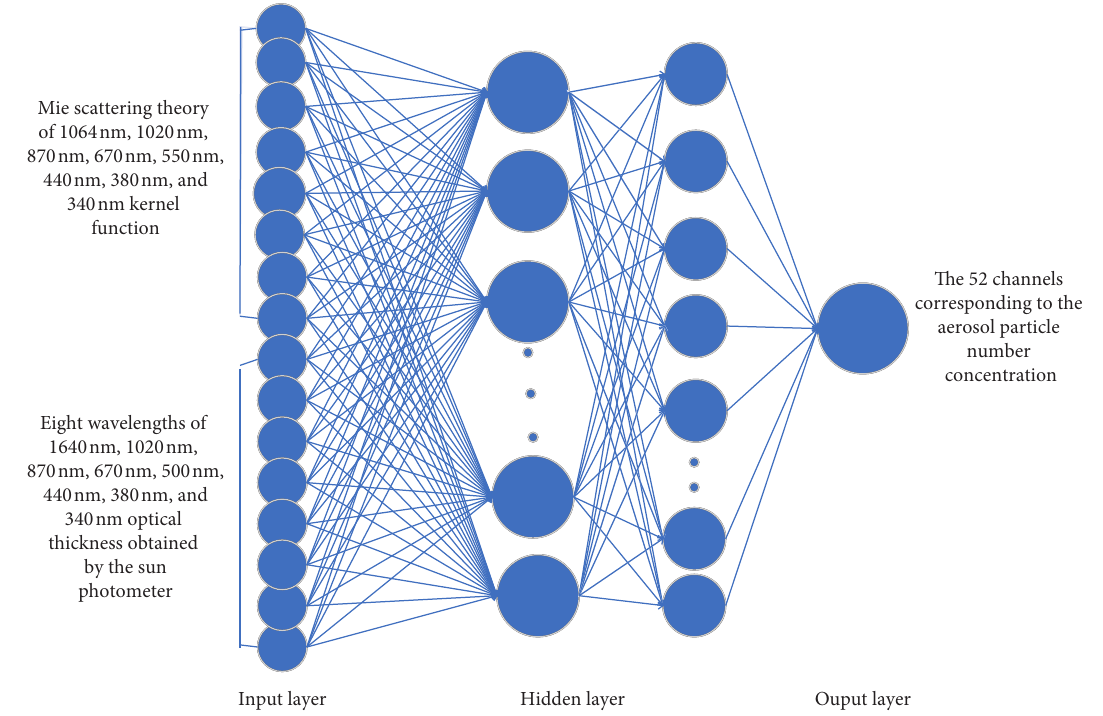
Figure 3: The structure diagram of the BP neural network prediction